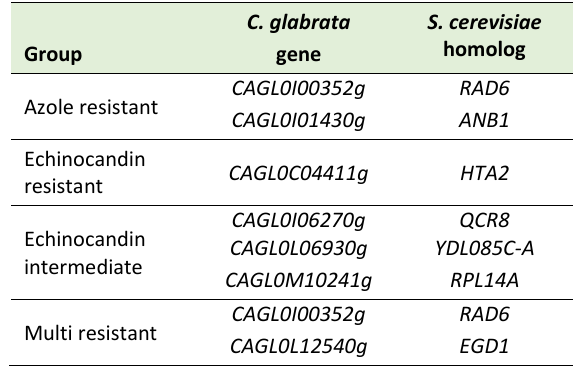
TABLE 4. Genes affected by nonsynonymous mutations oc- curring exclusively in resistant isolates when compared to susceptible